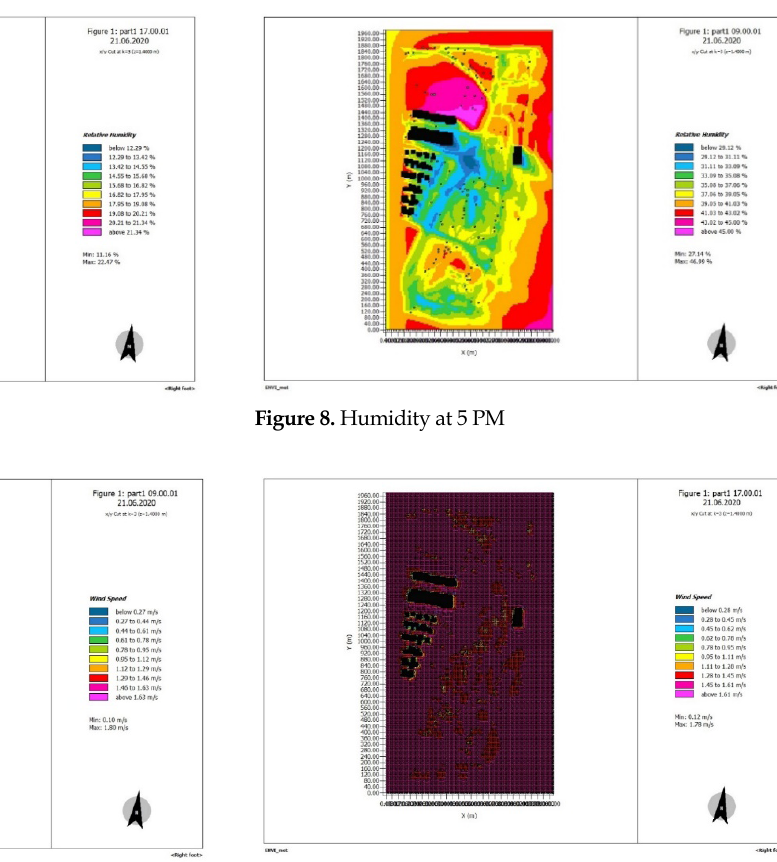
Figure 9. Wind speed at 9 AM Figure 10. Wind speed at 5